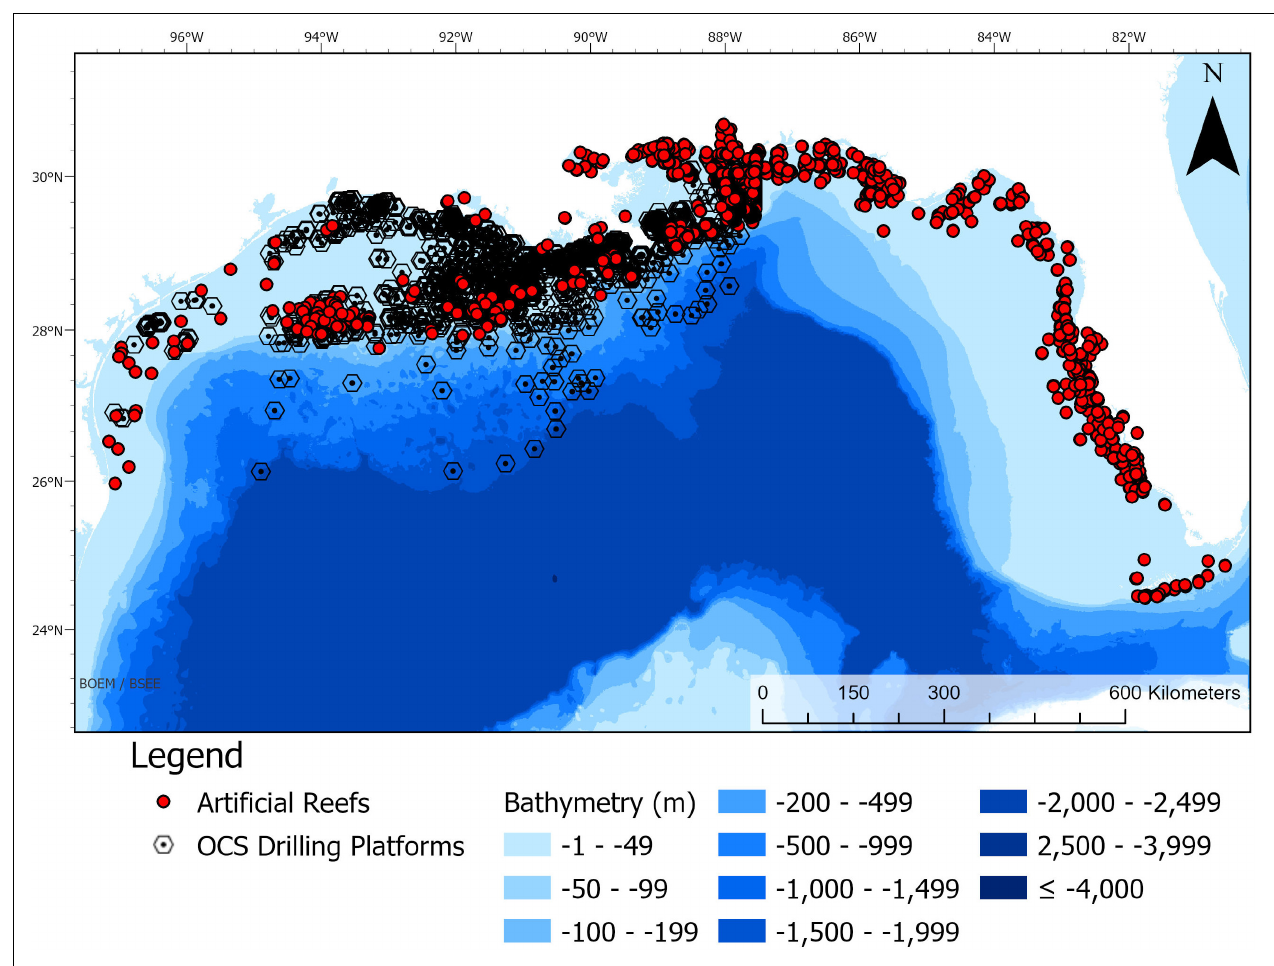
FIGURE 1 | Total artificial reefs of nGoM (red) and outer continental shelf drilling platforms (black) shown with bathymetry in meters. Data from NOAA (2016) and BSEE/BOEM Data Center